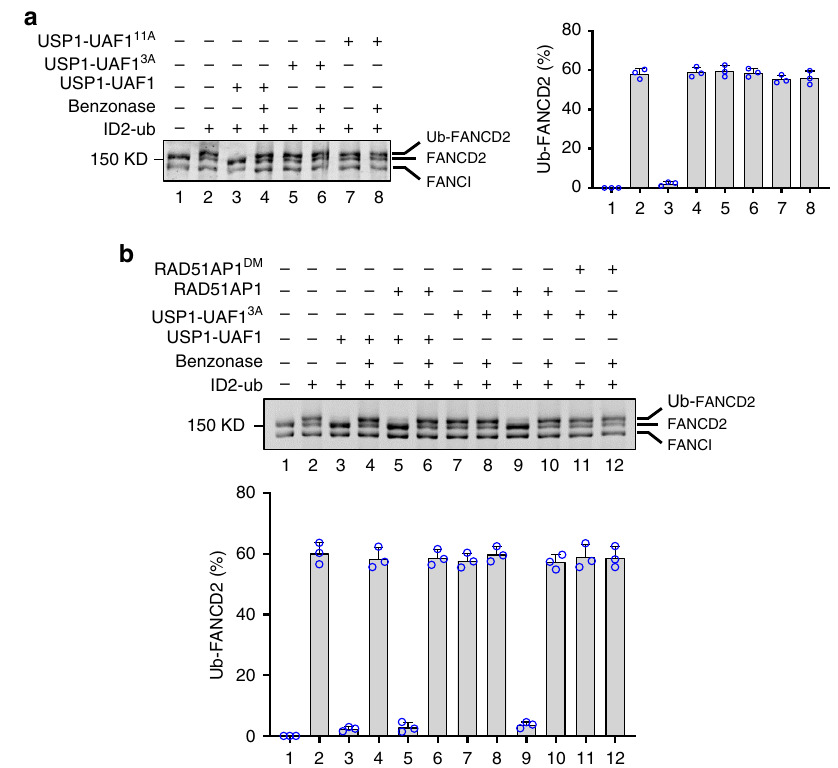
Fig. 3 Role of UAF1 and RAD51AP1 DNA binding in FANCD2 deubiquitination. a Deubiquitination of FANCD2 by USP1-UAF1 that harbored wild type or mutant UAF1. The error bars represent the mean + S.D. of data from three independent experiments. b Testing of RAD51AP1 and RAD51AP1 DM in FANCD2 deubiquitination. The error bars represent the mean + S.D. of data from three independent